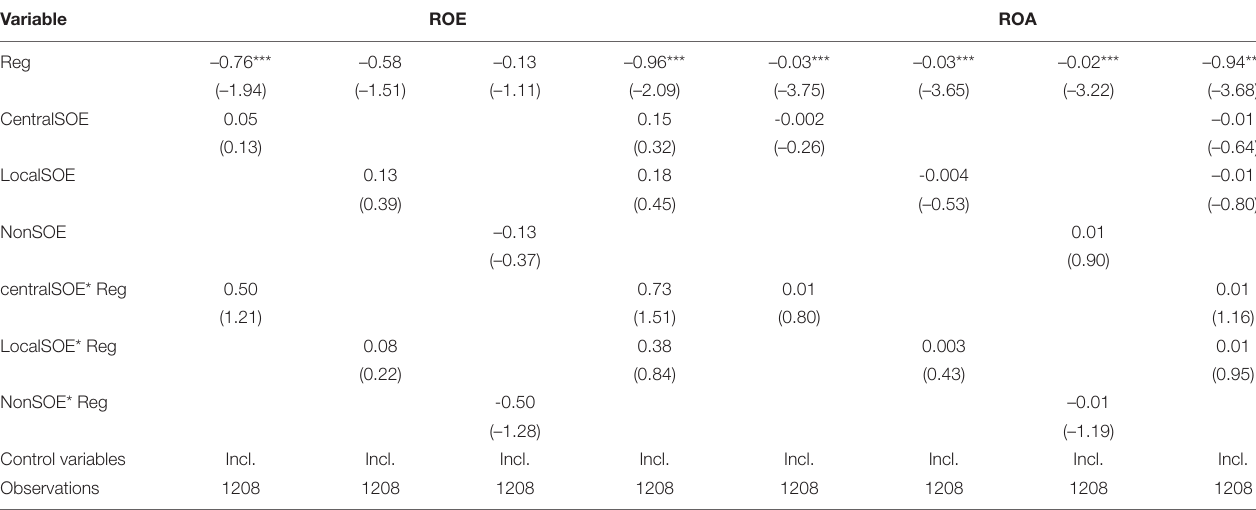
TABLE 6 | Additional test of the effect of compensation regulation on performance.